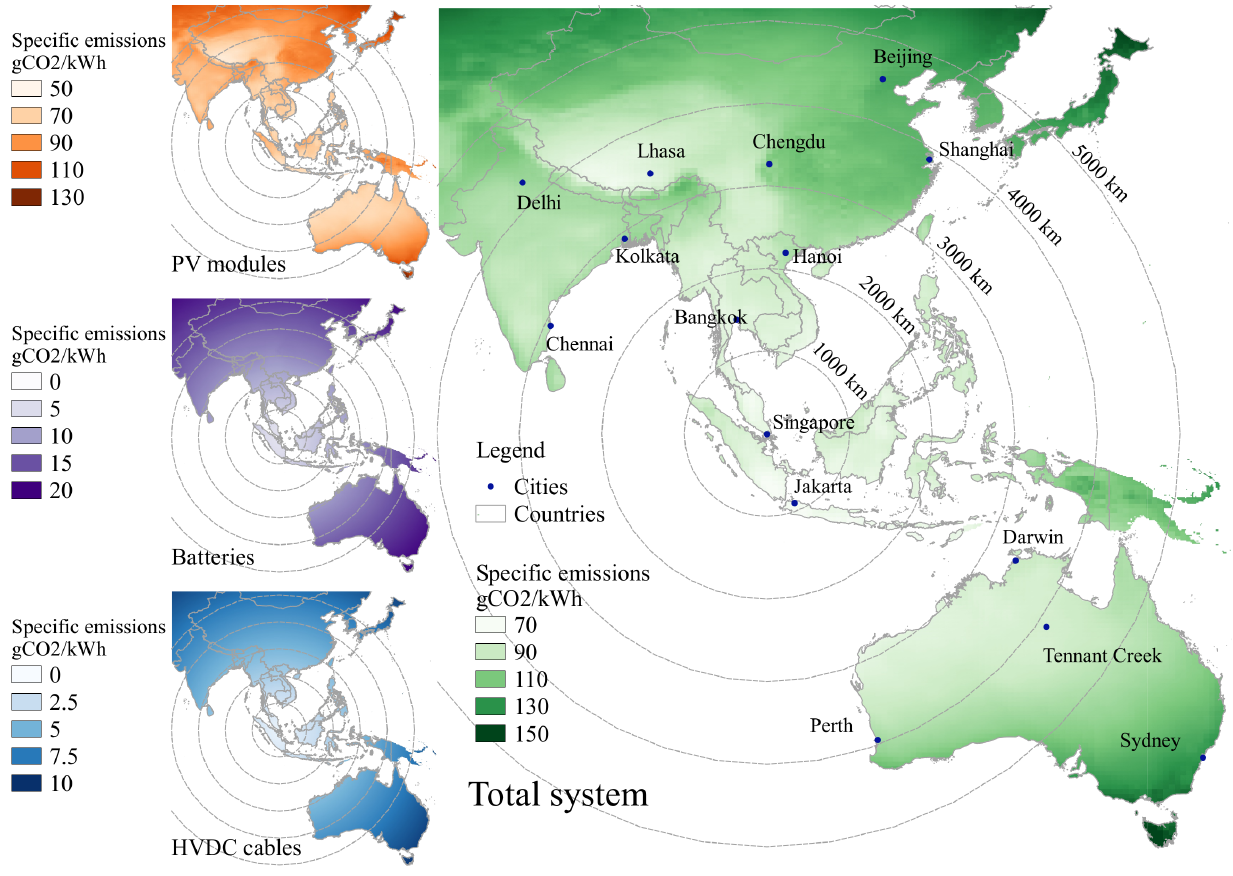
Figure 7. Specific CO 2 emissions per unit of electricity imported for the PV modules, battery storage system, and HVDC cable ( left ) and for the total system ( right